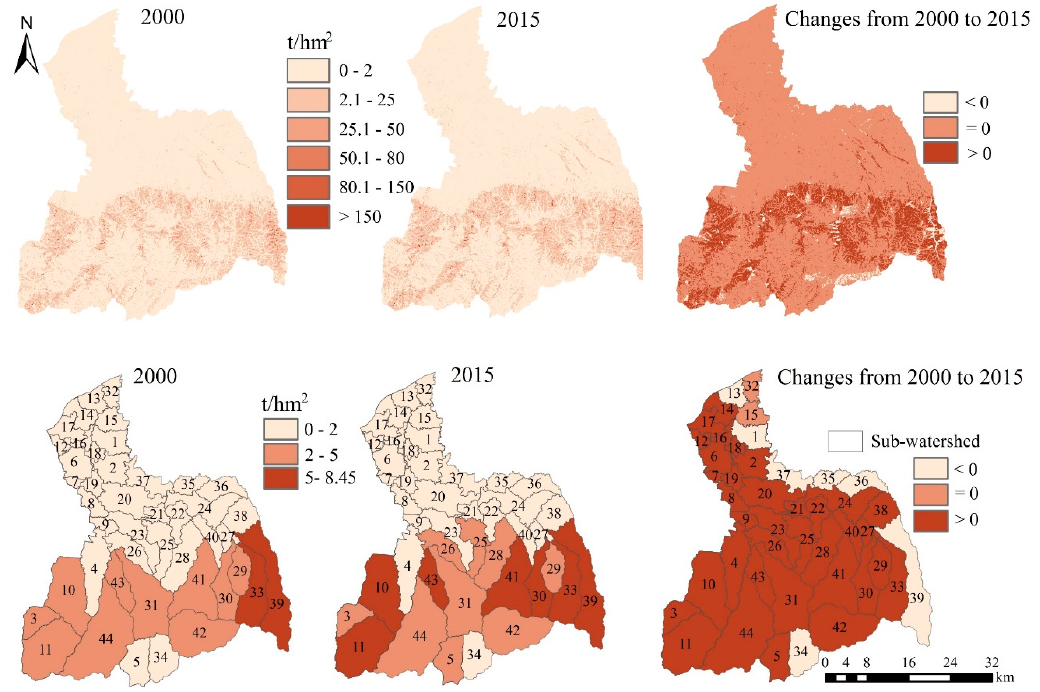
Figure 10. The spatial distribution and spatiotemporal changes of carbon emissions.